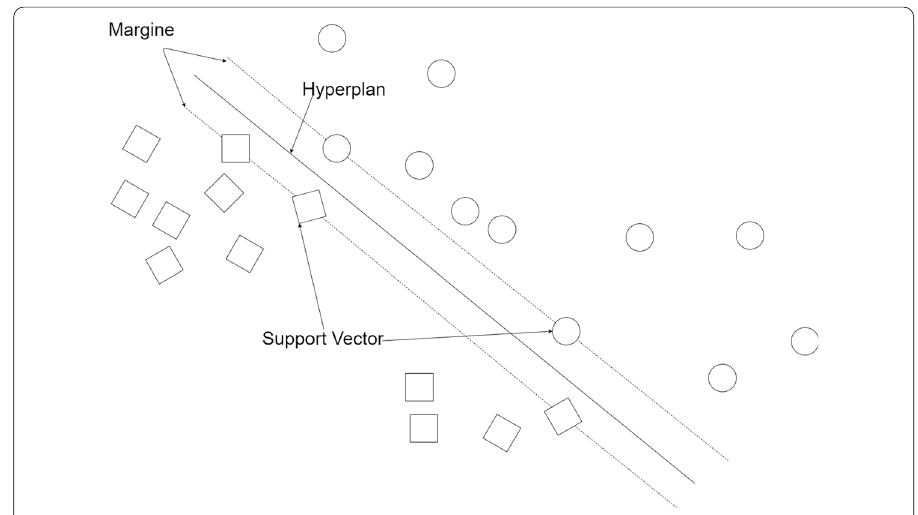
Fig. 4 SVM Algorithm